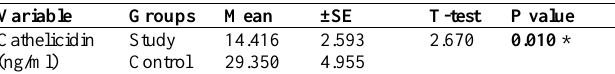
Table 1: Concentration of salivary cathelicidin and statistical difference in the study and control groups